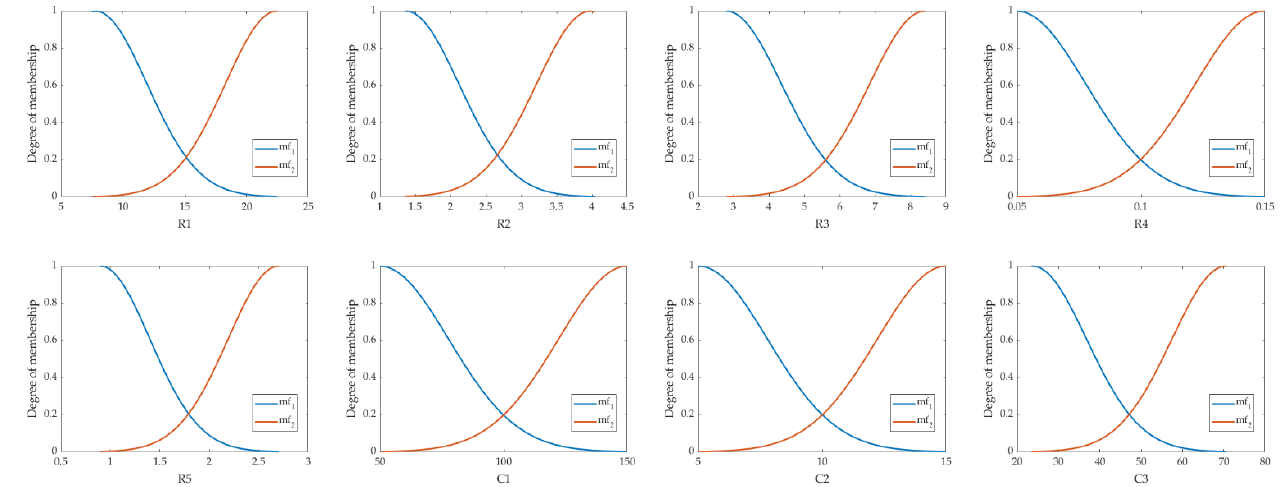
Figure 9. Membership functions obtained after tuning the FIS for THD (2nd step).